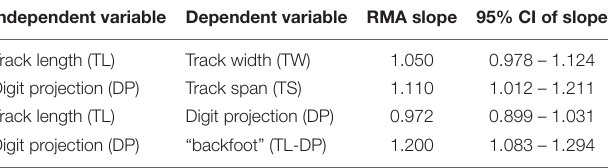
TABLE 3 | Summary of reduced major axis analysis where CI between 0.95 and 1.05 are